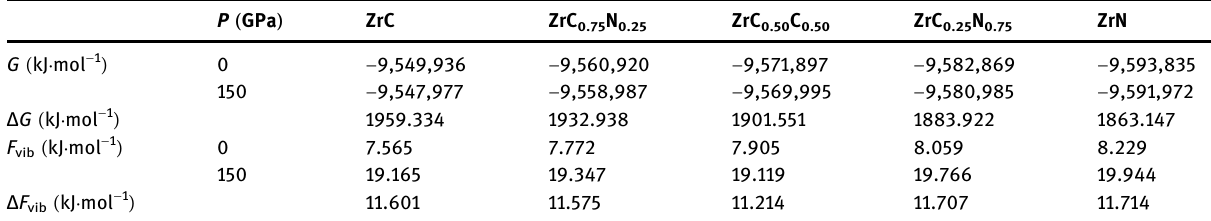
Table 4: Gibbs free energy values and the contribution of the vibration in G at the pressure of 150 GPa